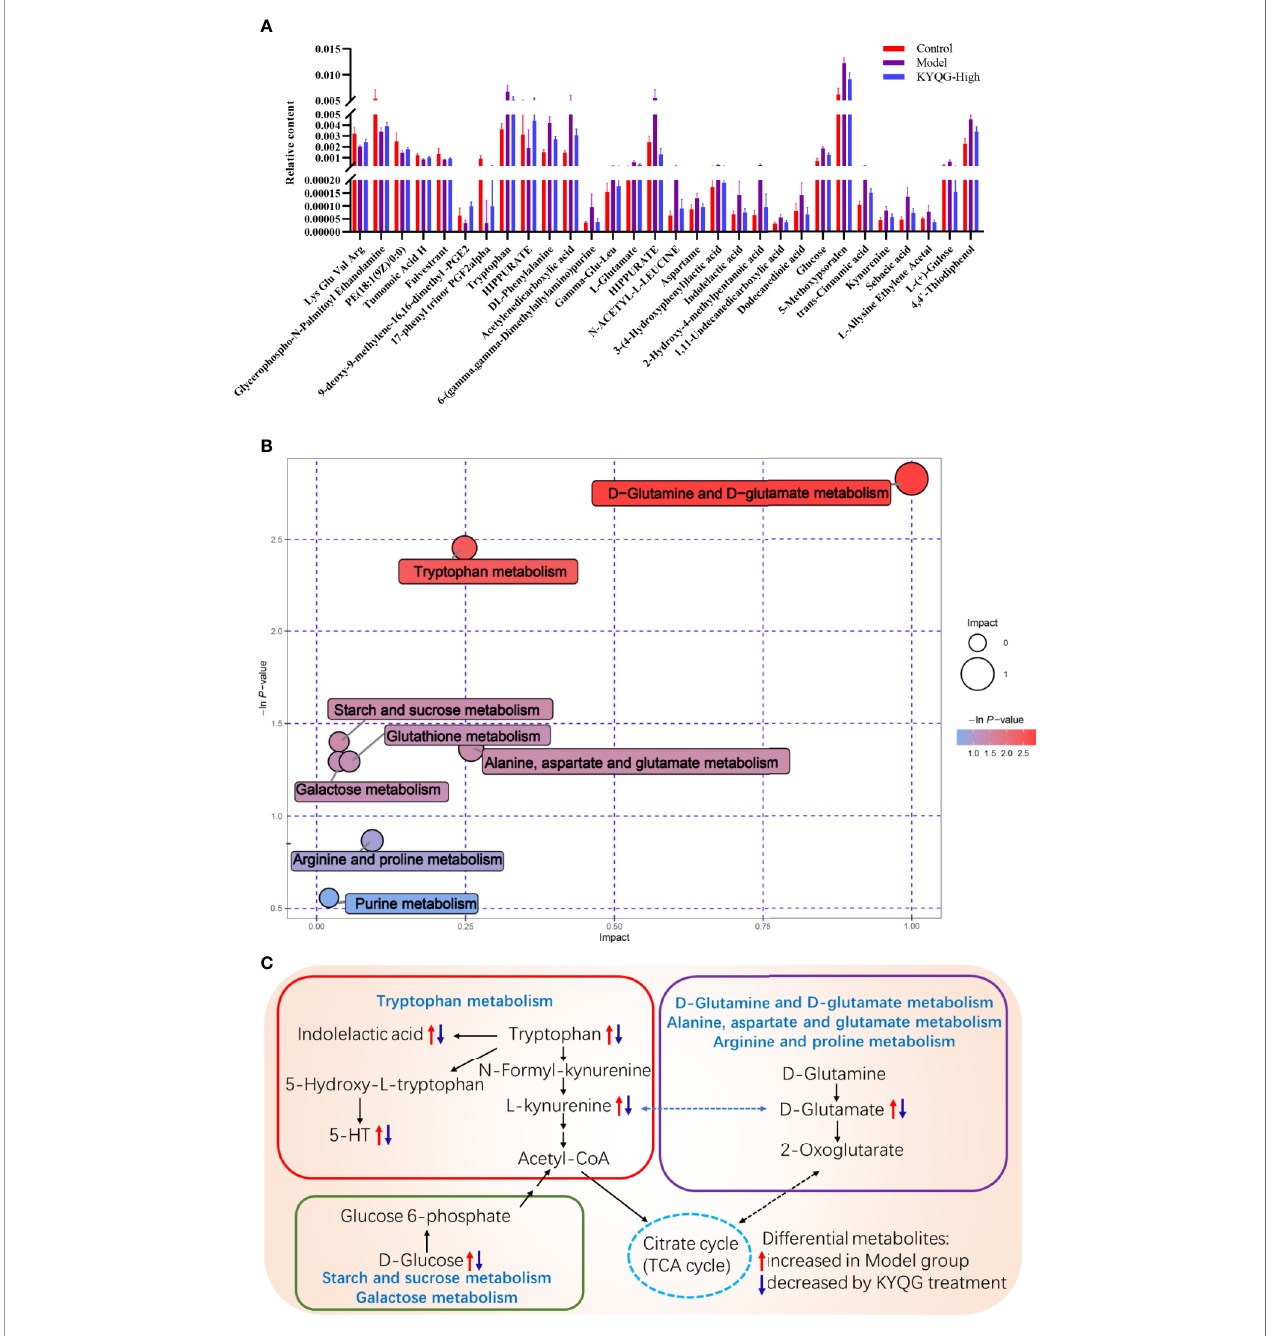
FIGURE 4 | The relative levels of 30 regulated serum metabolites in rats after Kouyanqing Granule (KYQG) treatment (A) . Metabolic pathway analysis results based on the 30 regulated serum metabolites after Kouyanqing Granule (KYQG) treatment (B) . Summaries of metabolic pathways (C)